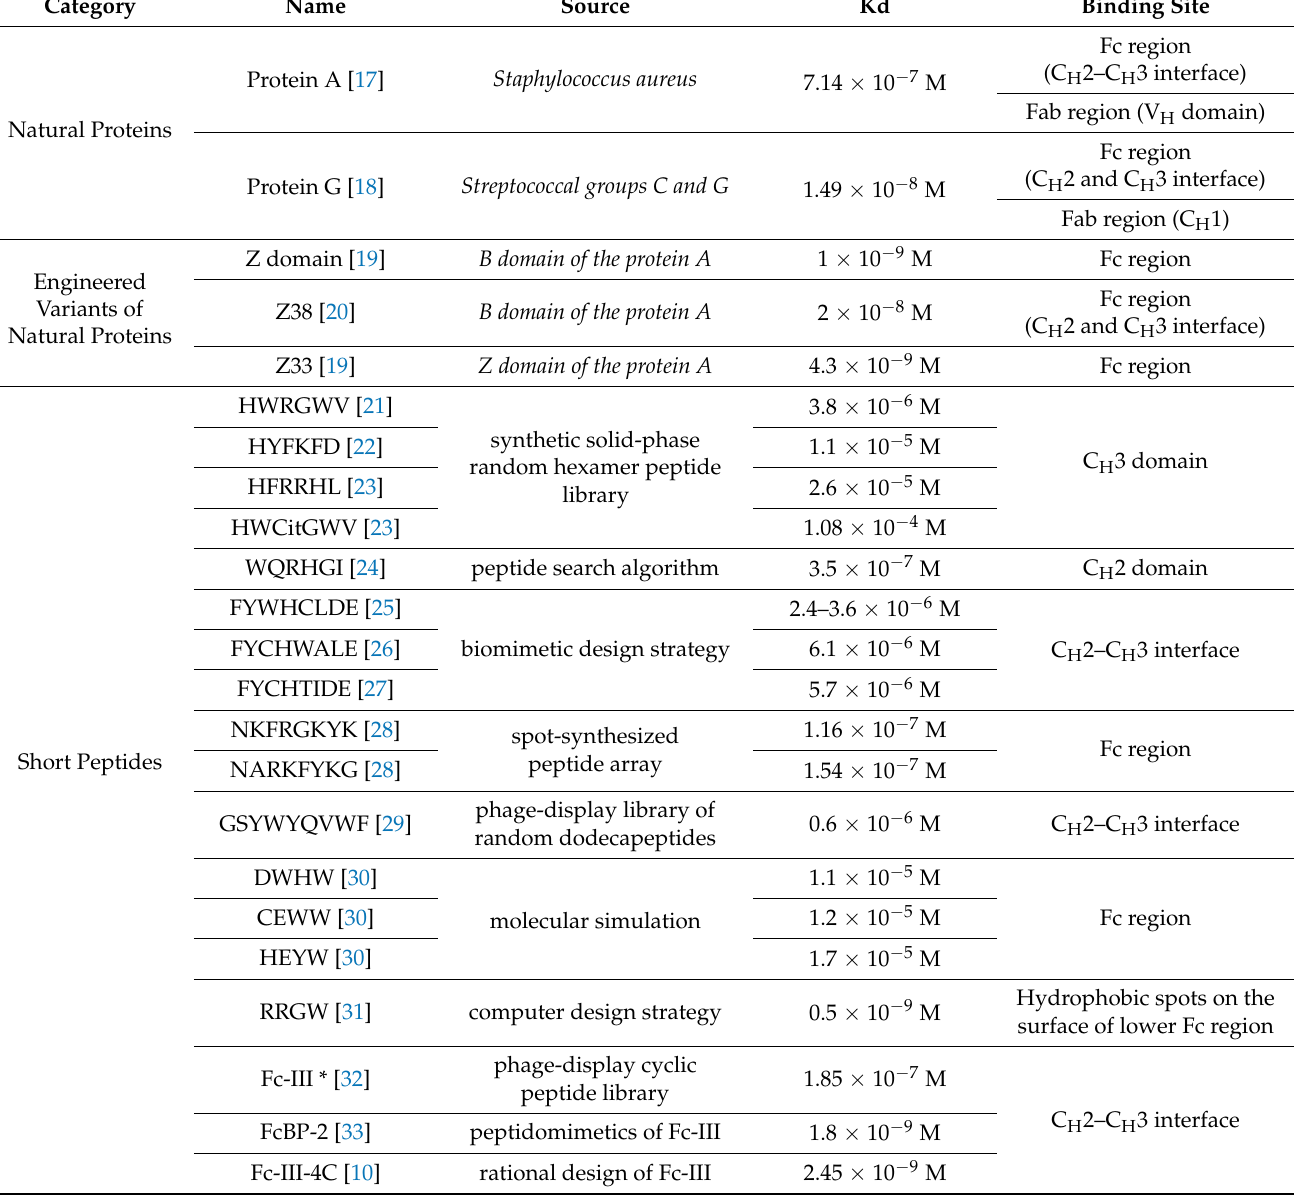
Table 1. Commonly used IgG Fc affinity